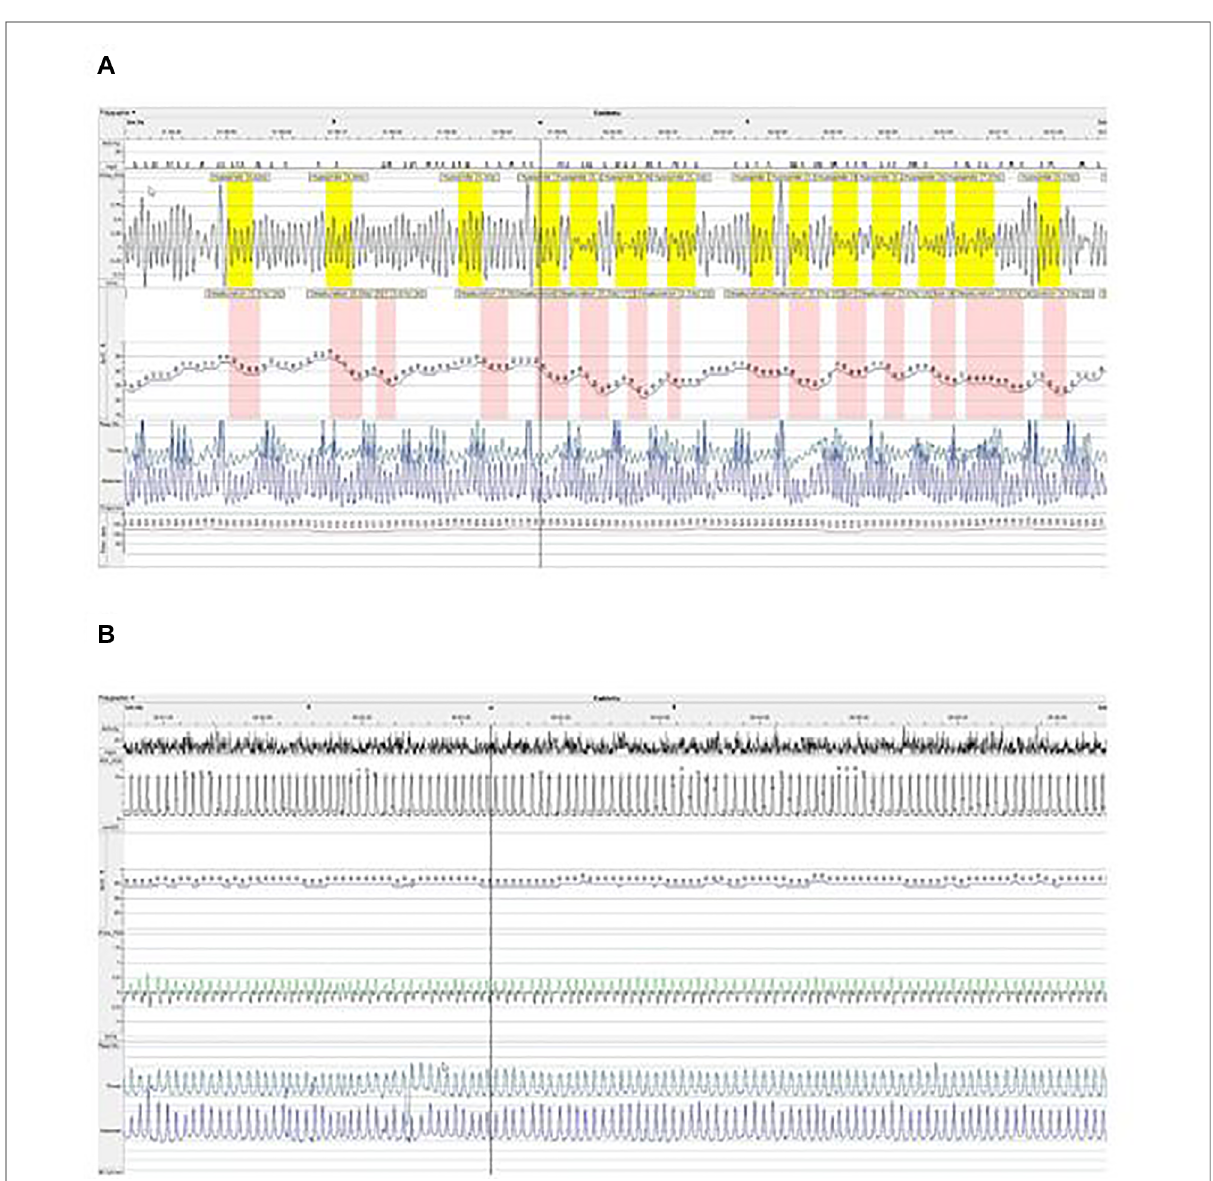
FIGURE 1 Polygraphy after adenotonsillectomy without NIV treatment ( A ) and under NIV treatment ( B ) in ( A , B ), we show extracts from polygraph plot with nasal fl ux (XFlow), oxygen saturation (SpO2), thoracic and abdominal movements and cardiac pulse. In ( A ), we see an obstructive breathing pattern with frequent hypopneas characterized by a drop of air fl ow associated with desaturations ≥ 3% of oxygen. In ( B ), under NIV, we see a regular breathing pattern with a complete disappearance of obstructive events and